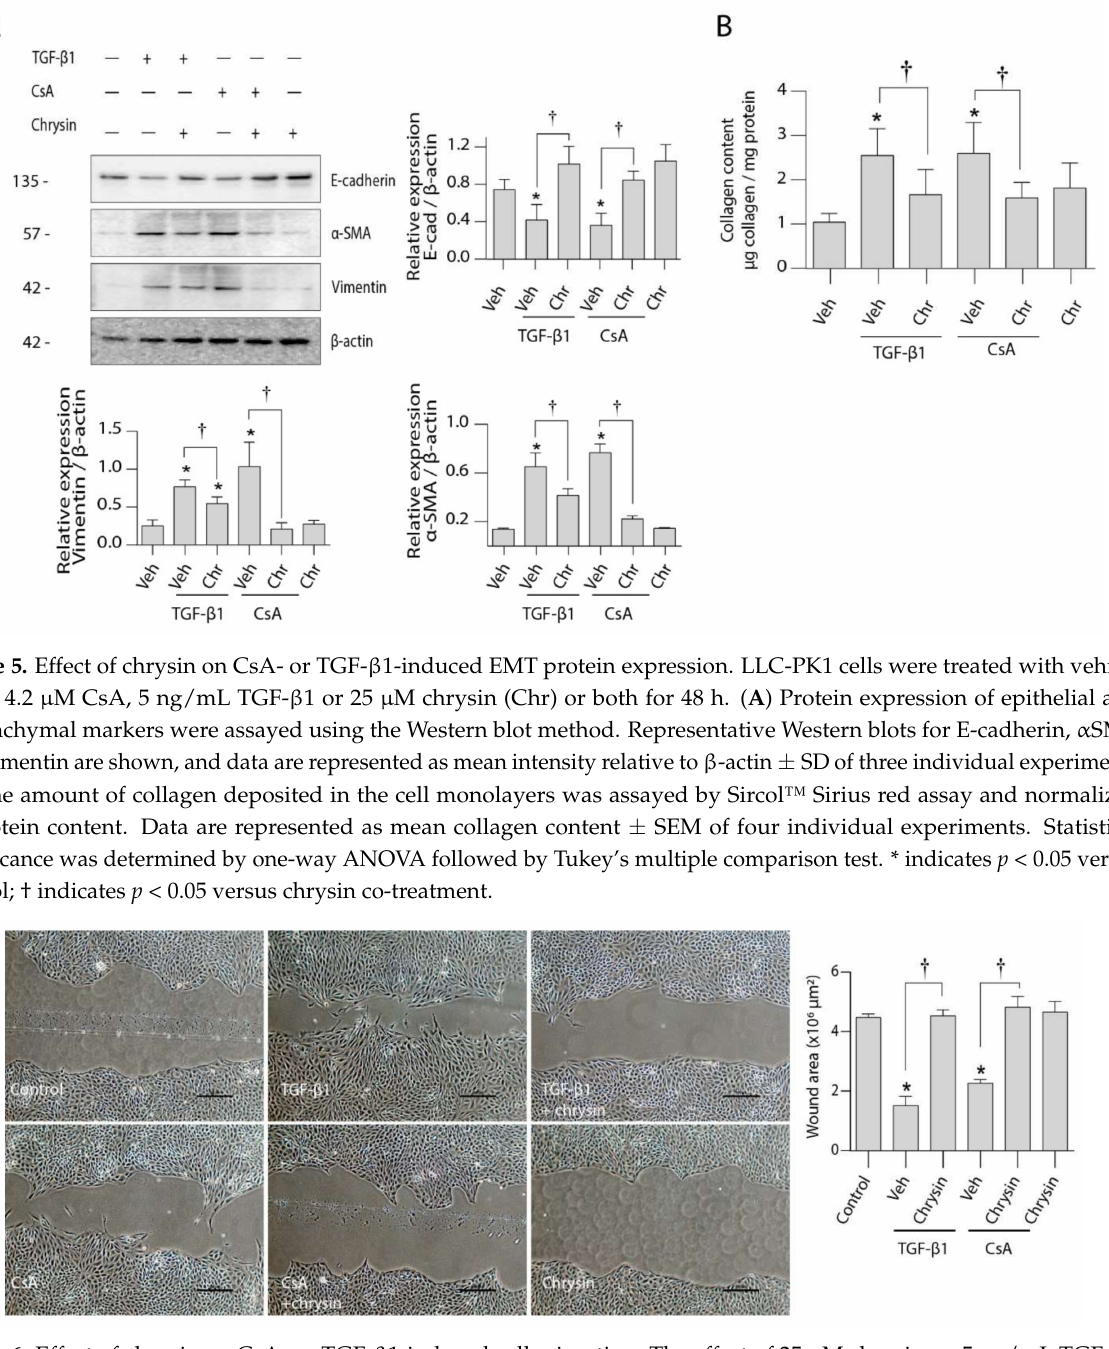
Figure 6. Effect of chrysin on CsA- or TGF- β 1-induced cell migration. The effect of 25 µ M chrysin on 5 ng/mL TGF- β 1- or 4.2 µ M CsA-induced LLC-PK 1 cell migration was determined by a wound healing assay. Representative micrographs are shown, and data are represented as mean wound area ± SEM of three individual experiments. Statistical analysis was performed by one-way ANOVA followed by Tukey’s multiple comparison test. * indicates p < 0.05 versus control; † indicates p < 0.05 versus chrysin co-treatment.